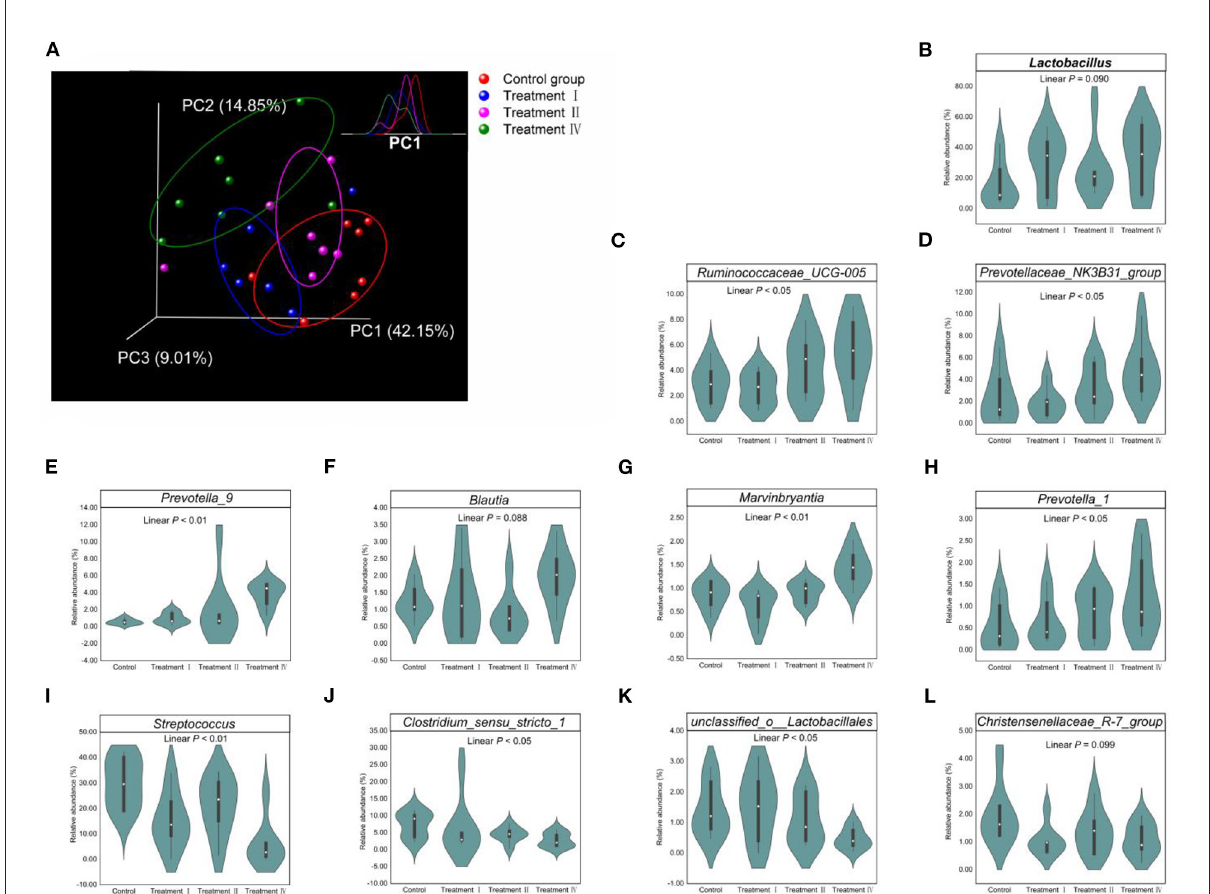
FIGURE4 Effect of dietary fiber on fecal microbiota. (A) Scatterplot from PCoA of fecal bacterial communities based on Bray_Curtis distance. Top right panel showed that the density distribution of the projection in PC1. (B–L) Linear change of microbial relative abundance in the top 21 genera. Only change with statistical support ( p < 0.10) was showed in this picture. Polynomial contrasts analysis was